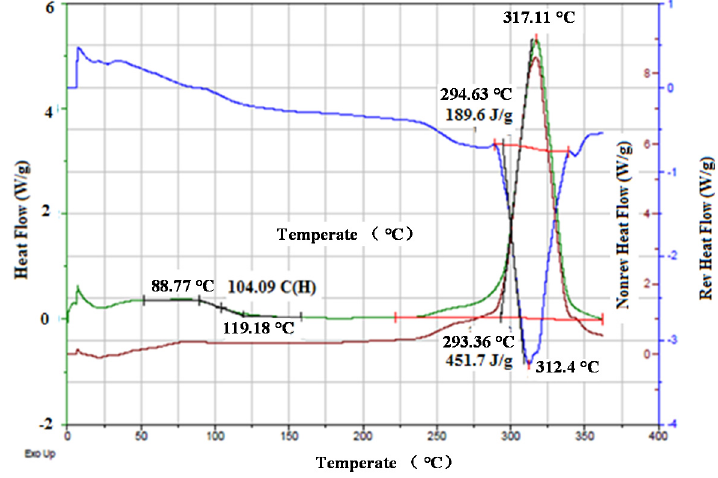
Figure 5. The DSC thermogram of the PAN fibers for heat flow, non ‐ reverse heat flow and reverse heat flow.